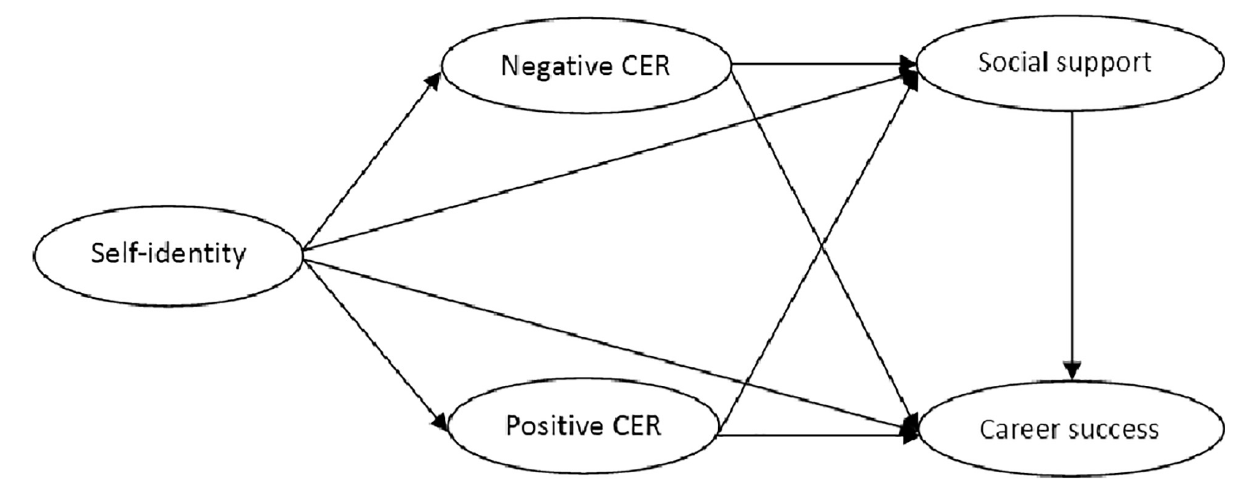
FIGURE 1 | The multiple mediator model of self-identity and career success hypothesized: (1) Nurses’ self-identity will affect cognitive emotion regulation. (2) Positive emotion regulation is conductive to seeking social support and further promoting career success. (3) Negative emotion regulation is not conductive to seeking social support and further hindering career success. (4) Cognitive emotion regulation and social support play a chain mediating role between self-identity and career success.